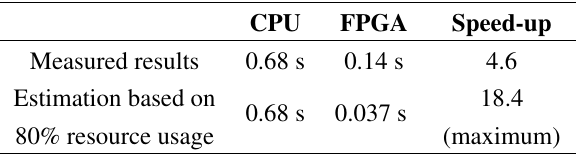
Table 3. Comparison of the processing time using proposed atom-pair list based